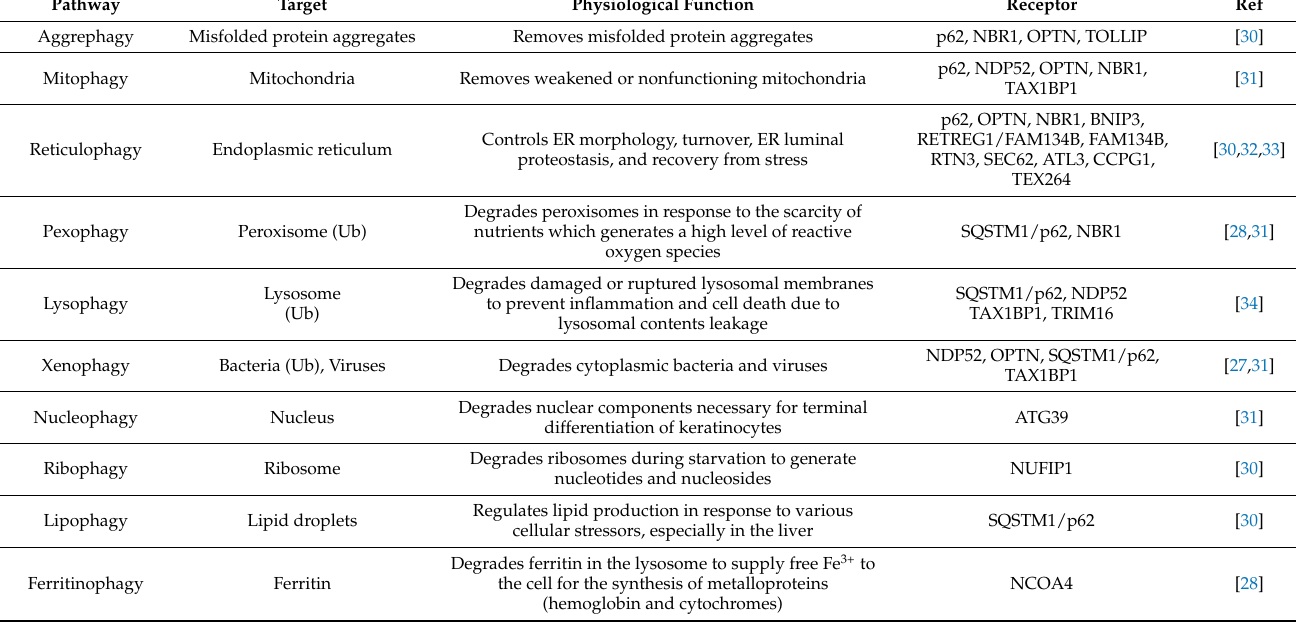
Table 1. Comparison of the different types of selective autophagy.